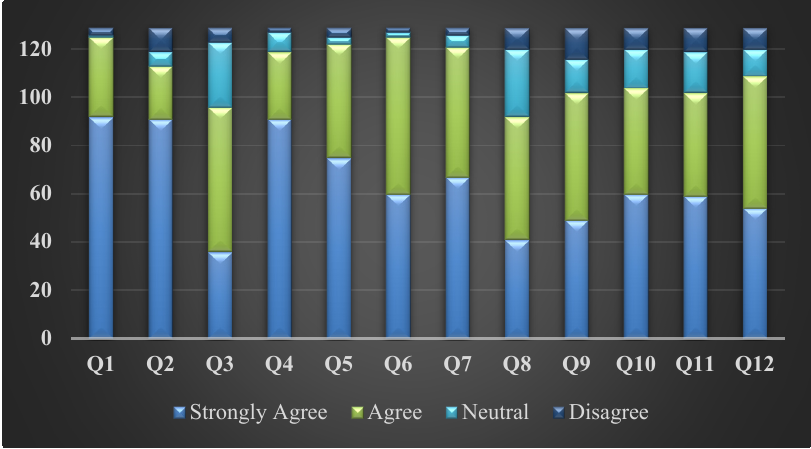
Fig. 5. Responses on IoT engineering program viability and